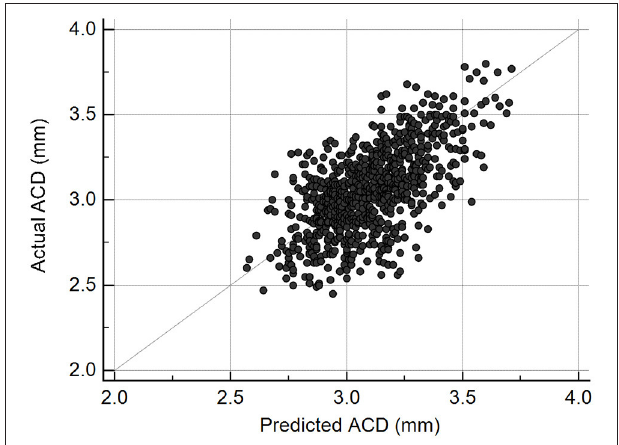
FIGURE 2 | Scatterplot illustrating the relationship between deep learning-predicted and actual anterior chamber depth (ACD) measurements from Lenstar ( n = 831, r = 0.63, P < 0.001).